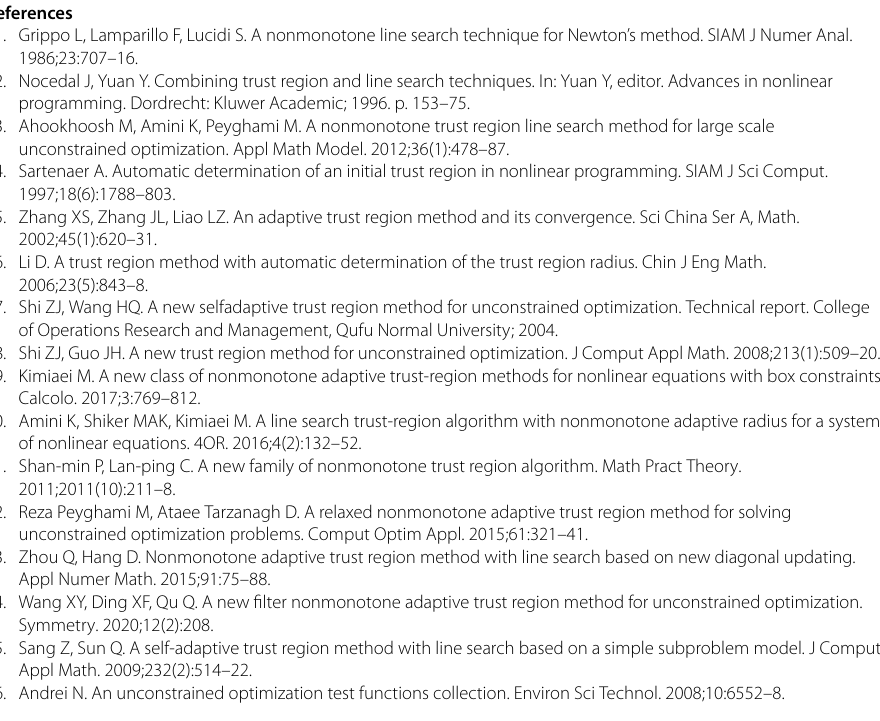
global convergence and superlinear convergence, respectively. Numerical